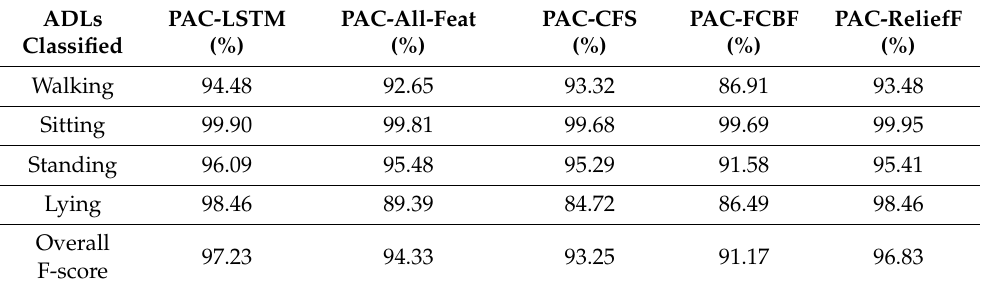
Table 3. Performance analysis of different PAC systems using the test set.